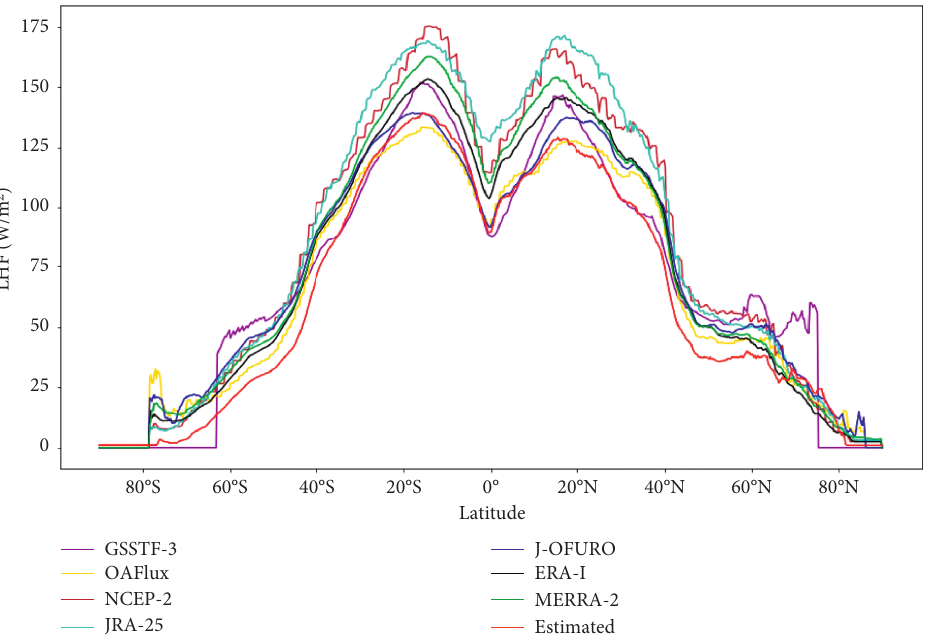
Figure 10: Zonal annual mean of LHF for ocean LHF computed from eight